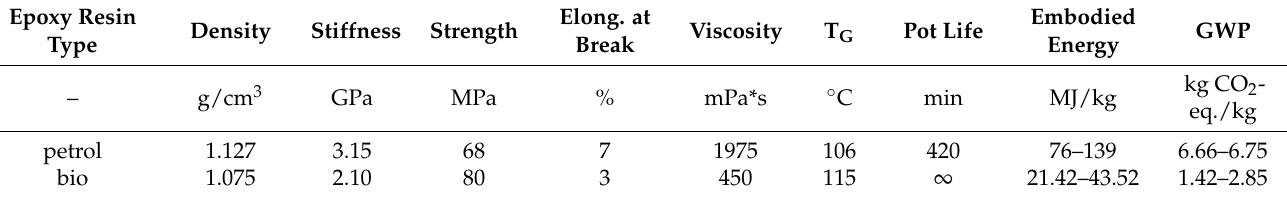
Table 3. Overview of the selected resin